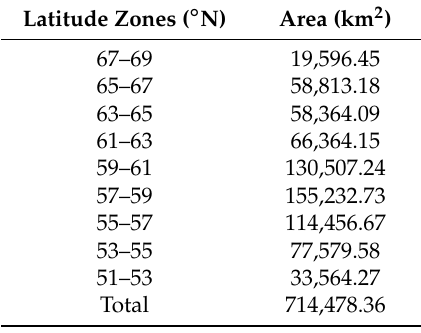
Figure 1. Location of the study area. Table 1. The areas of each latitude zone.